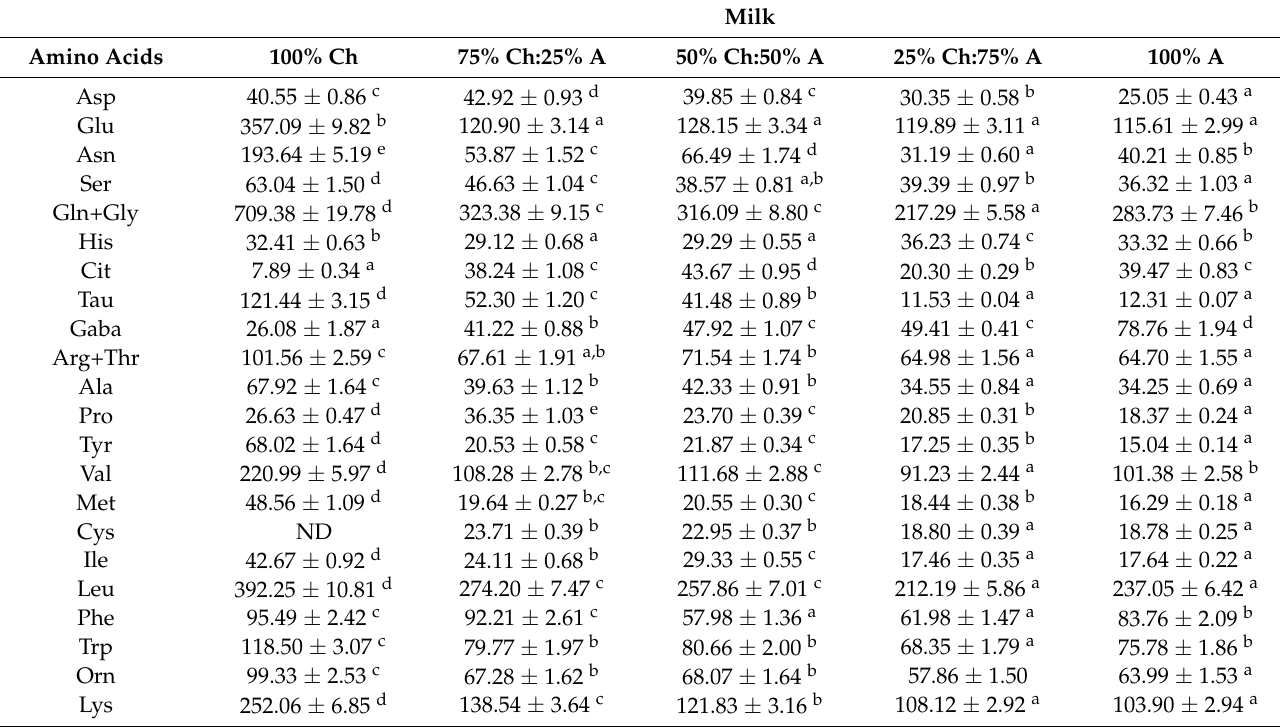
Table 2. Average free amino acids content (expressed as mg 100 g − 1 of cheese) in Zamorano cheese made with milk from Churra (Ch) and Assaf (A) breed after 240 days’ ripening.